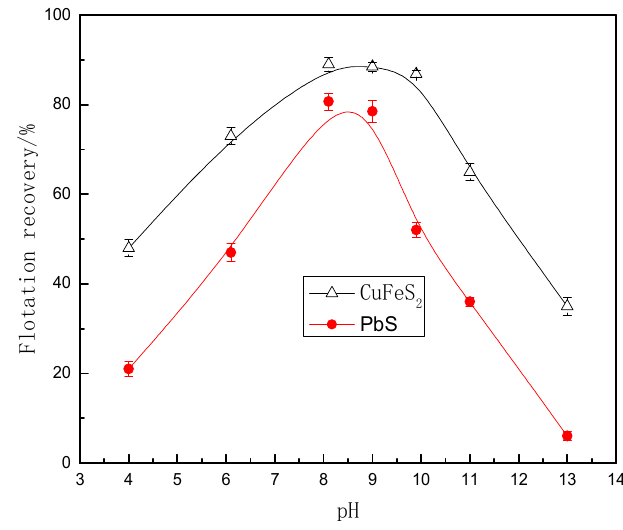
Figure 2. Recoveries of chalcopyrite and galena as a function of pH (IPETC: 8 × 10 − 4 mol/L).